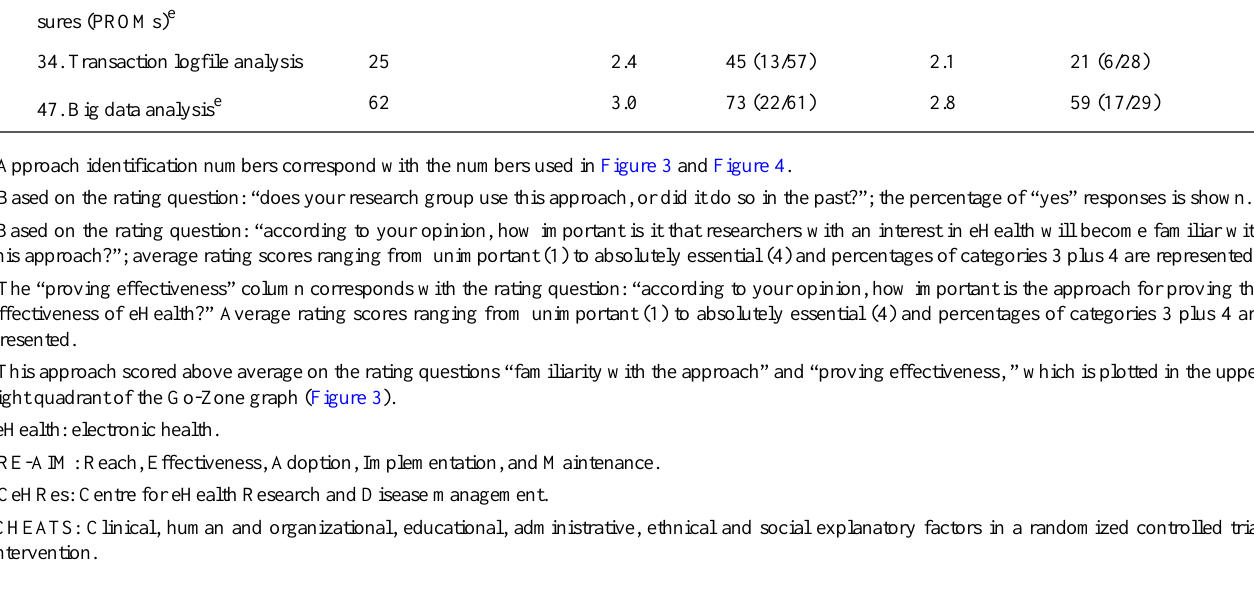
Figure 3. Go-Zone graph. The numbers refer to the evaluation approaches listed in Table